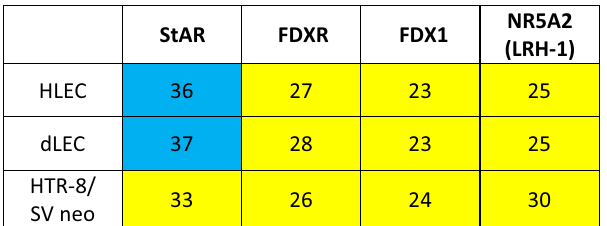
Table 6. Gene expression analysis in HLEC, dLEC and HTR-8/SVneo. mRNA expression of steroidogenic proteins involved in de-novo steroid hormone production in HLEC, dLEC and HTR-8/SV neo. Expression levels are shown as ct values per 12.5 ng cDNA. Yellow: significant expression (ct < 35). Blue: no or very low expression (ct ≥ 35). CYP17A1 (steroid-17α-hydroxylase), CYP21A2 (steroid-21-hydroxylase), CYP11B1 (steroid-11β- and negative controls were run.